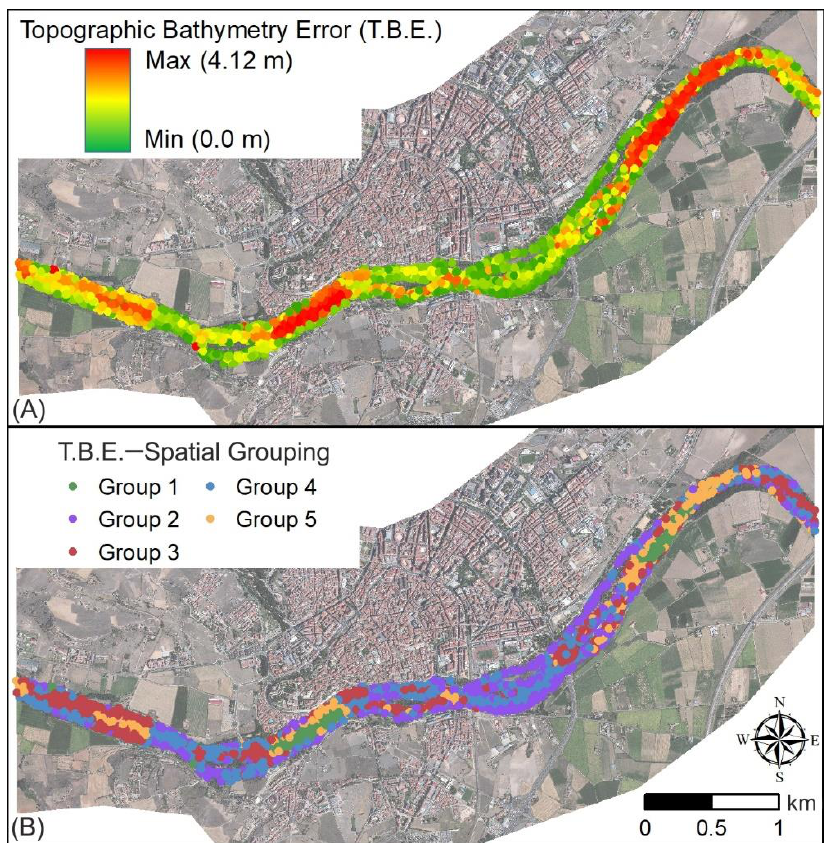
Figure 4. Topographic differences between the “real scenario” and the “LiDAR scenario” ( A ), where green colors show lower differences and red colors show higher topographic differences. A grouping analysis ( B ) of the errors without spatial constraints showed a non-uniform pattern.